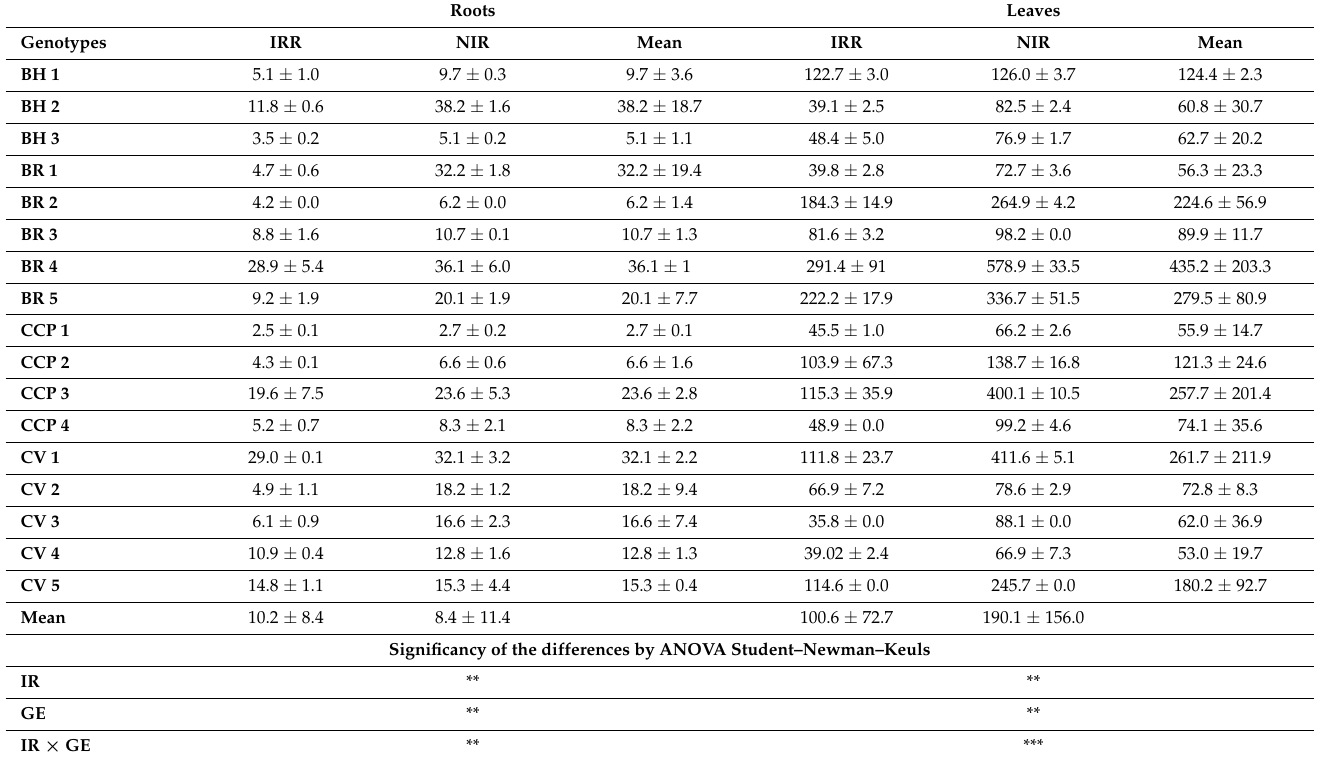
Table 4. Variation in the total amount of GLSs ( µ mol g − 1 d.w. ) in the roots and leaves in relation to the two experimental factors